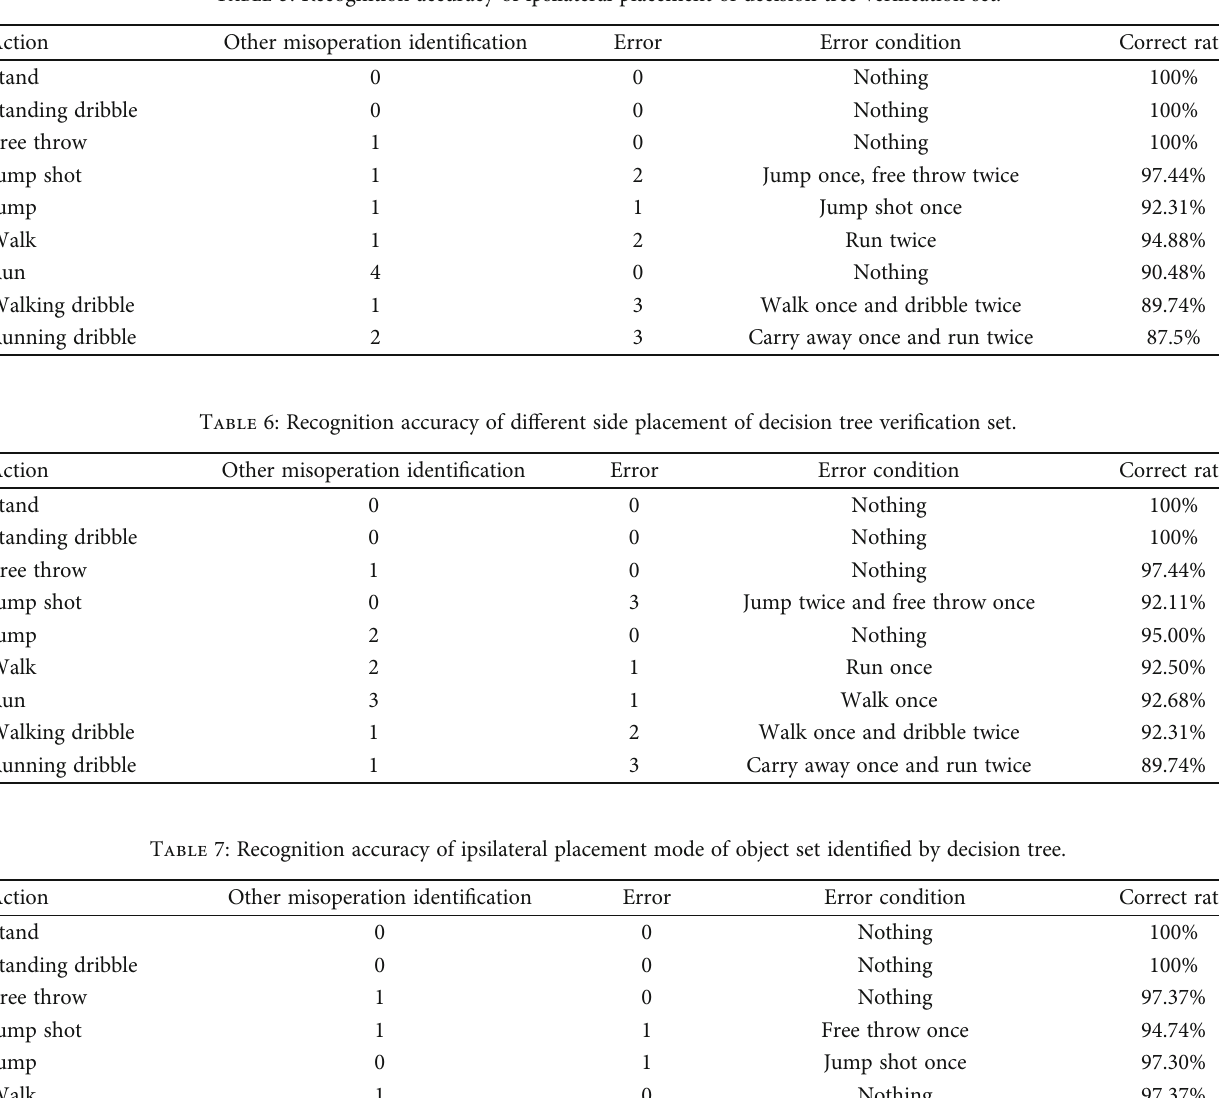
Table 5: Recognition accuracy of ipsilateral placement of decision tree veri fi cation set.